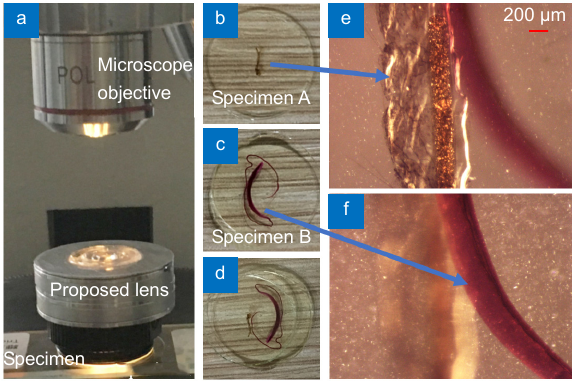
Fig. 5 | Imaging experiment using the movable electrowetting optofluidic lens . ( a ) Experiment setup. ( b ) Specimen A. ( c ) Specimen B. ( d ) Specimen A and B stacked together. ( e ) Focusing on specimen A. ( f ) Focusing on specimen